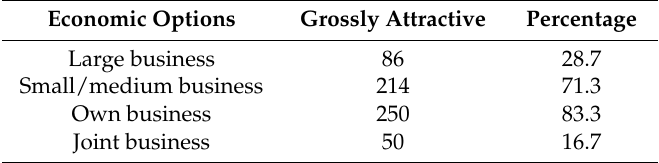
Table 4. Preference towards business options upon graduation (type of